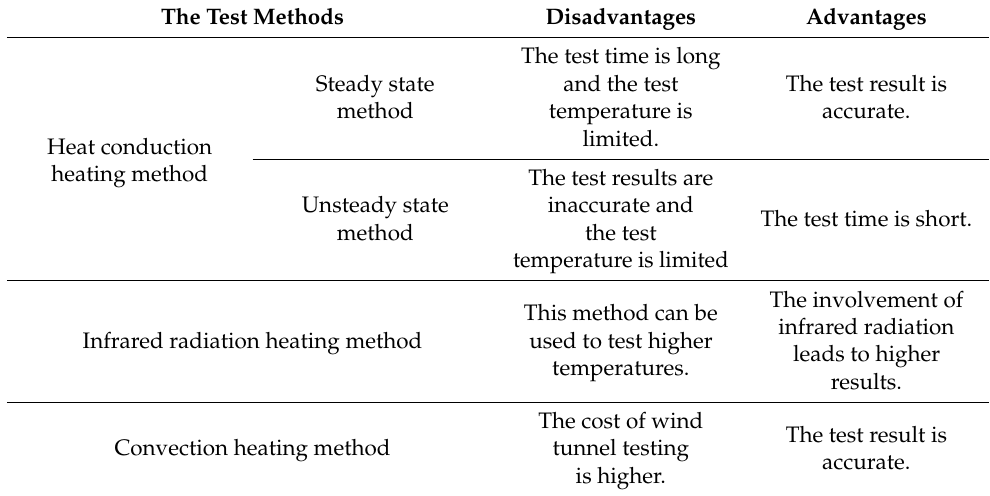
Table 3. The common test